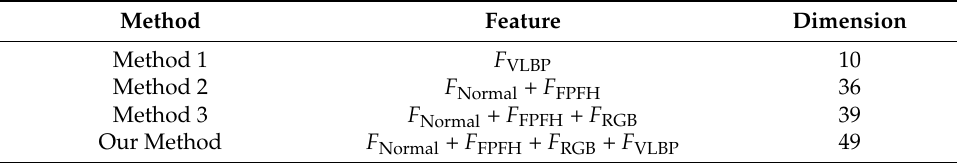
Table 5. Comparison with the four methods in terms of “Feature